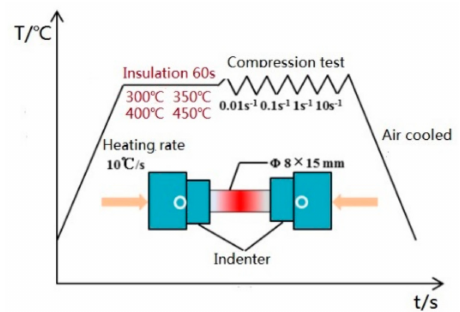
Figure 1. Schematic diagram of compression tests.